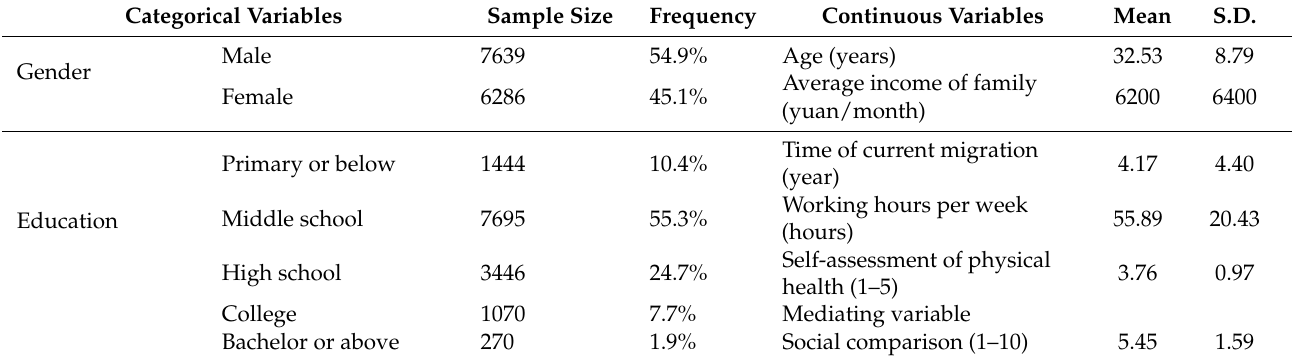
Table 1. Descriptive statistics of variables (sample size =